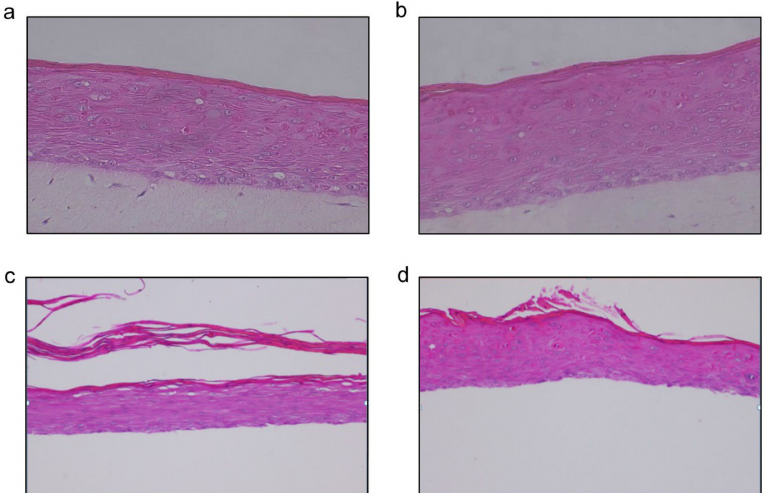
Figure 1. 3D human oral tissue model, untreated and treated with everolimus and stained with H and E at different time points. The pink color shows the epithelium which consists of keratinocytes. The top part of the epithelium is the stratum corneum (flat horizontal cells), followed by the stratum spinosum and stratum basalis at the bottom of the epithelium. ( a ) H and E staining of an untreated oral mucosa model (24 h), ( b ) H and E staining of an untreated oral mucosal tissue model (60 h), ( c ) H and E staining of an oral mucosal tissue model treated with 32 ng/mL everolimus (60 h), and ( d ) H and E staining of an oral mucosal tissue model treated with 64 ng/mL everolimus (60 h). The magnification factor for ( a – d ) was 40 ×